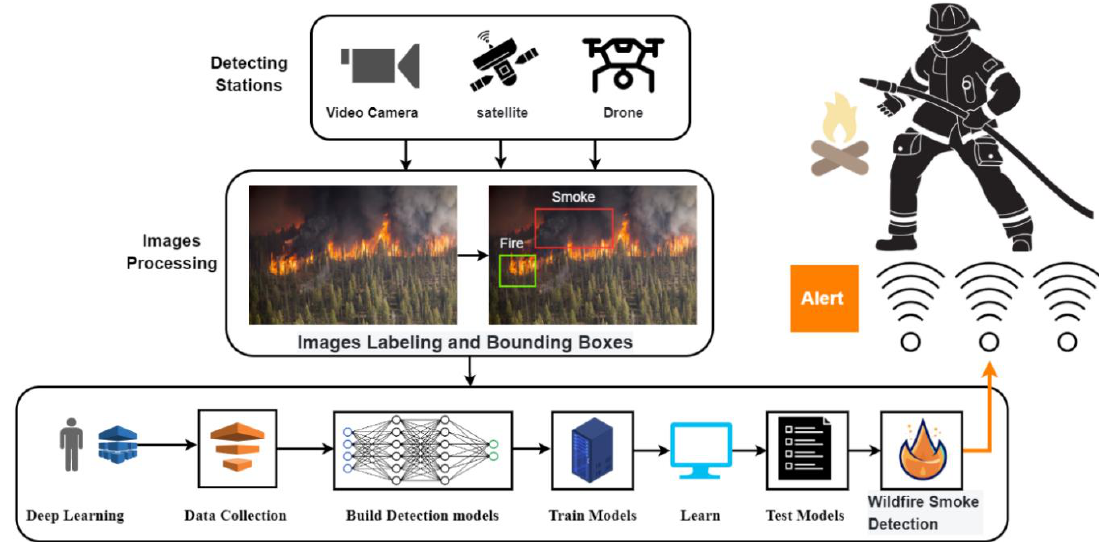
Figure 1. Wildfire smoke-detection operation flowchart using deep learning.